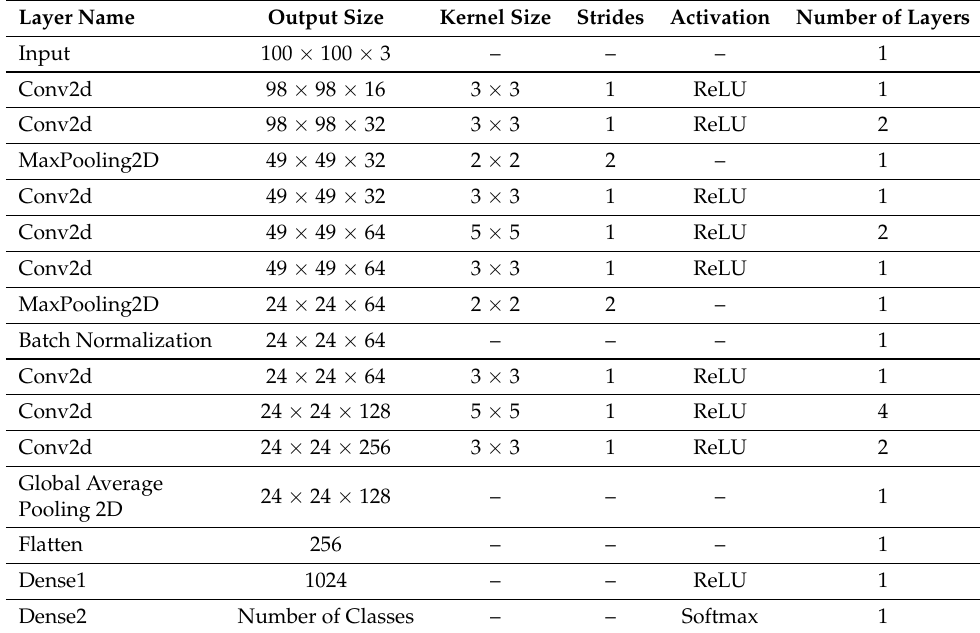
Table 1. An overview of proposed framework architecture for traffic sign